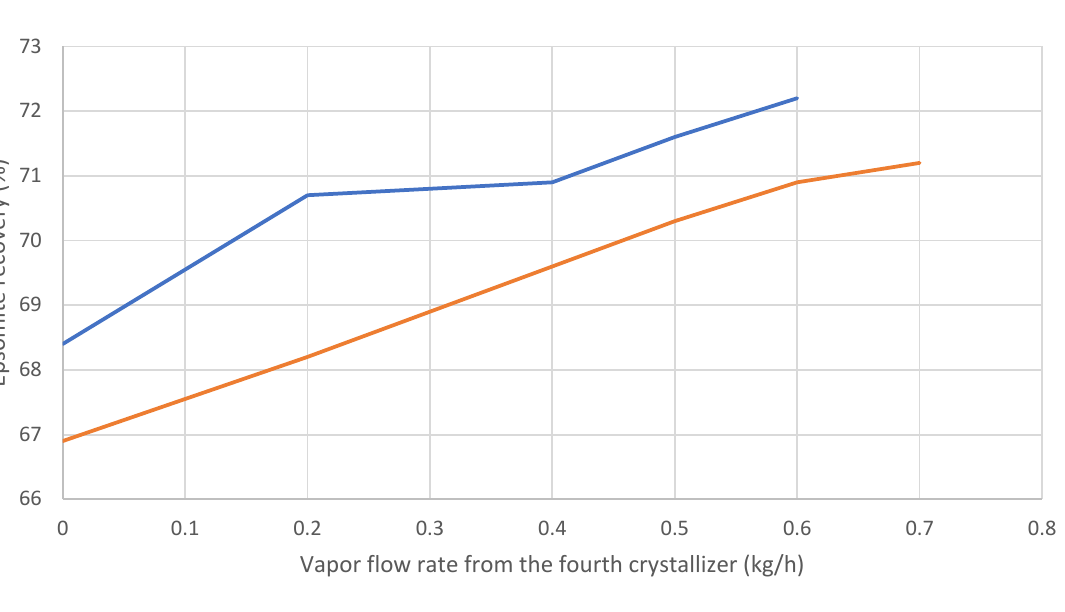
Figure 3. Evolution of halite recovery and crystal composition from the third crystallizer as a function of temperature with a vapor flow rate of 85 kg/h.